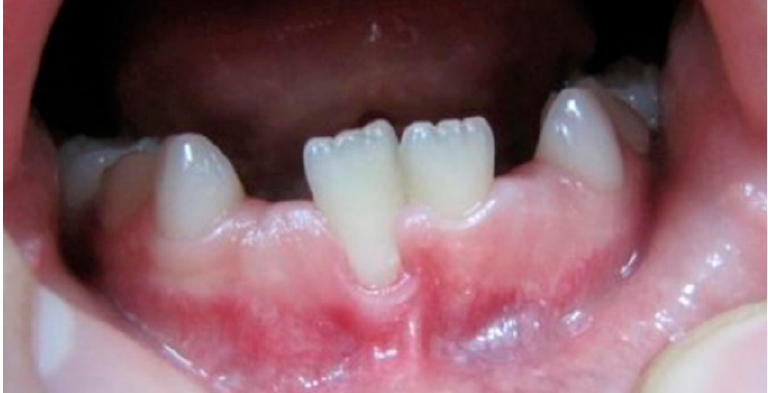
Figure 3. Pseudo-recession, lack of attached gingiva.